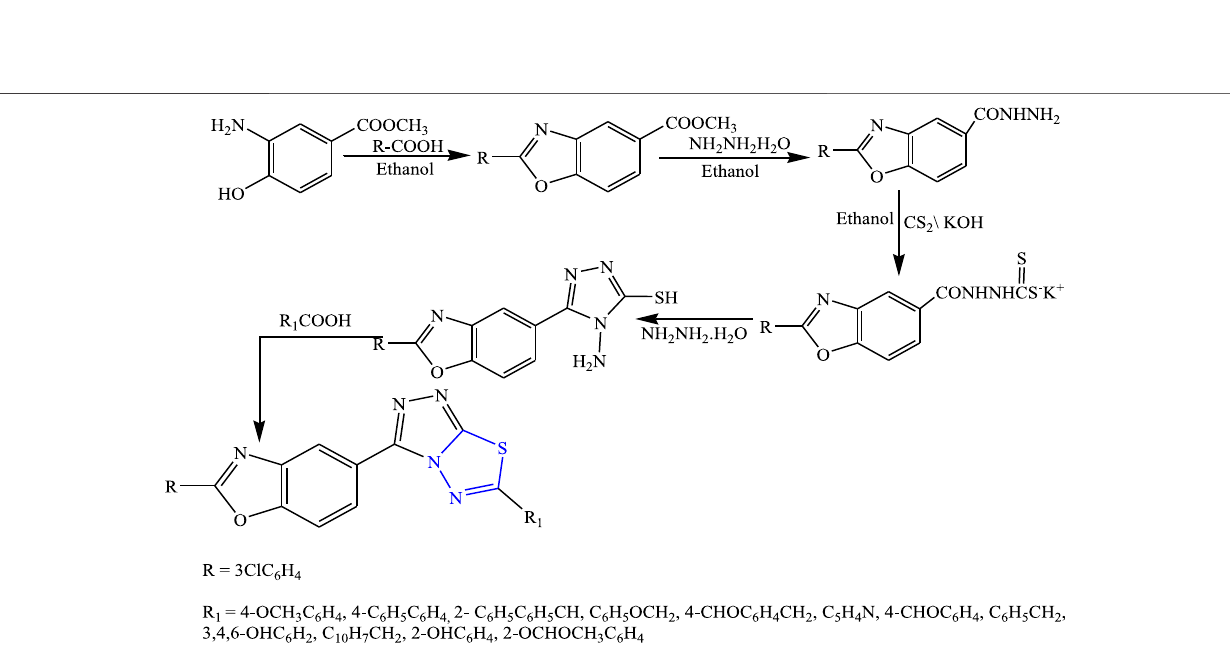
Frontiers in Chemistry |